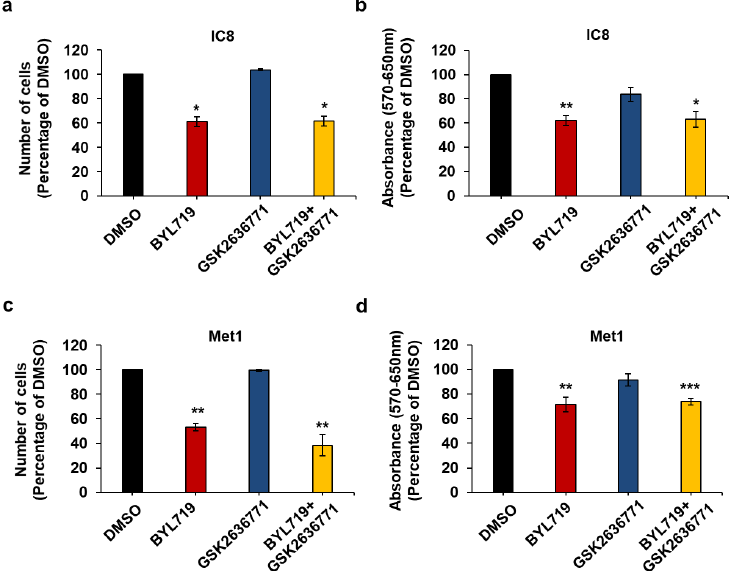
Figure 7. p110 β does not contribute to IC8 and Met1 cell growth and viability upon p110 α inhibition. IC8 ( a , b ) and Met1 ( c , d ) cells were treated with 1 µM of the indicated inhibitors alone or in combi- nation in complete medium supplemented with 10% FBS. Control cells were treated with DMSO. After 72 h, number of cells was assessed by cell counting ( a , c ) and cell viability was assessed by MTT assays ( b , d ). Data are expressed as percentage of results from control cells and are means ± SEM (apart from ( c ), means ± SD) from n = 3 ( a ), n = 4 ( b ), n = 3 (( c ), apart from GSK2636771, n = 2) and n = 6 ( d ) independent experiments performed in duplicate ( a , d ) or triplicate ( b , d ). * p < 0.05, ** p < 0.01, *** p < 0.001 vs. DMSO. Taken together these data indicate that IC8 and Met1 cells retain the same sensitivity to PI3K inhibition as normal keratinocytes and suggest that p110 α is the main PI3K regu- lating growth and viability of these cSCC cell lines. In contrast to IC8 and Met1 cells, BYL719 had only a very small effect on IC1 (Figure 8a) and T11 (Figure 8c) cell numbers with reduction not reaching statistical significance in MTT assays (Figure 8b,d). No effect was detected in MTT assays upon treatment of IC1 cells with lower concentrations of either BYL719 or GSK2636771 (Supplementary Figure S6d). None of the other inhibitors affected IC1 or T11 cells at the concentration tested, apart from CAL101 reducing T11 cell numbers significantly (Figure 8c).